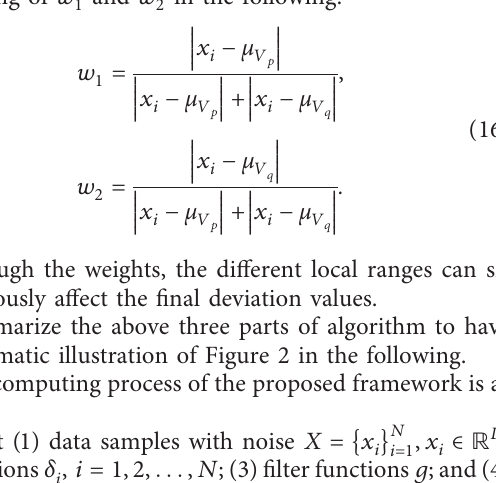
a manifold dimension reduction algorithm F : R D ⟶ R d . Procedure